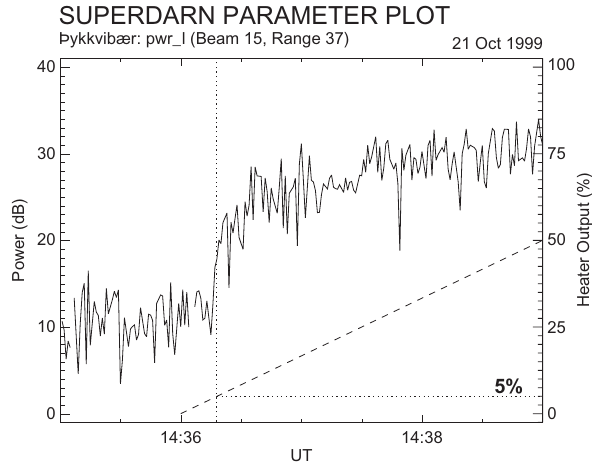
Fig. 10. Backscatter power received from the heated volume by the Pykkvibær radar (beam 5, range 37) during the up-going part of a similar heater cycle to that shown in Fig. 4. The dashed line shows the heater output power during this interval, given by the scale on the right hand side of the